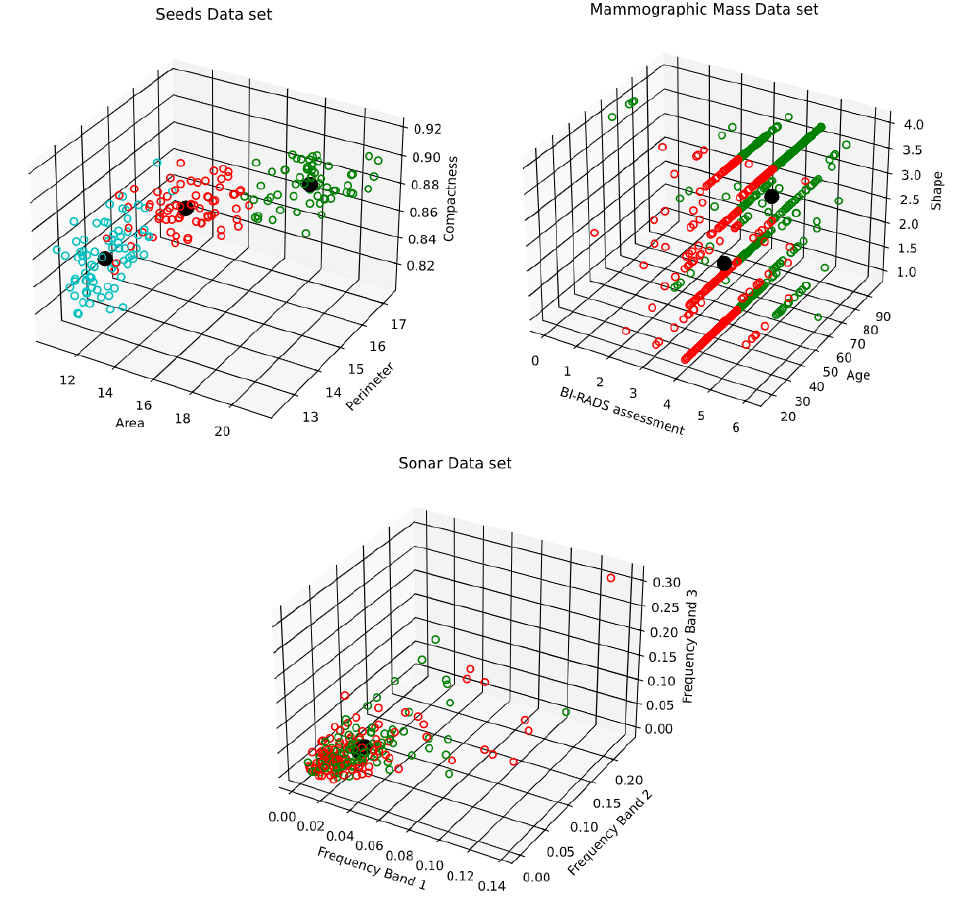
Figure 13. Visualization of the cluster centers using FCM on experimental data sets.